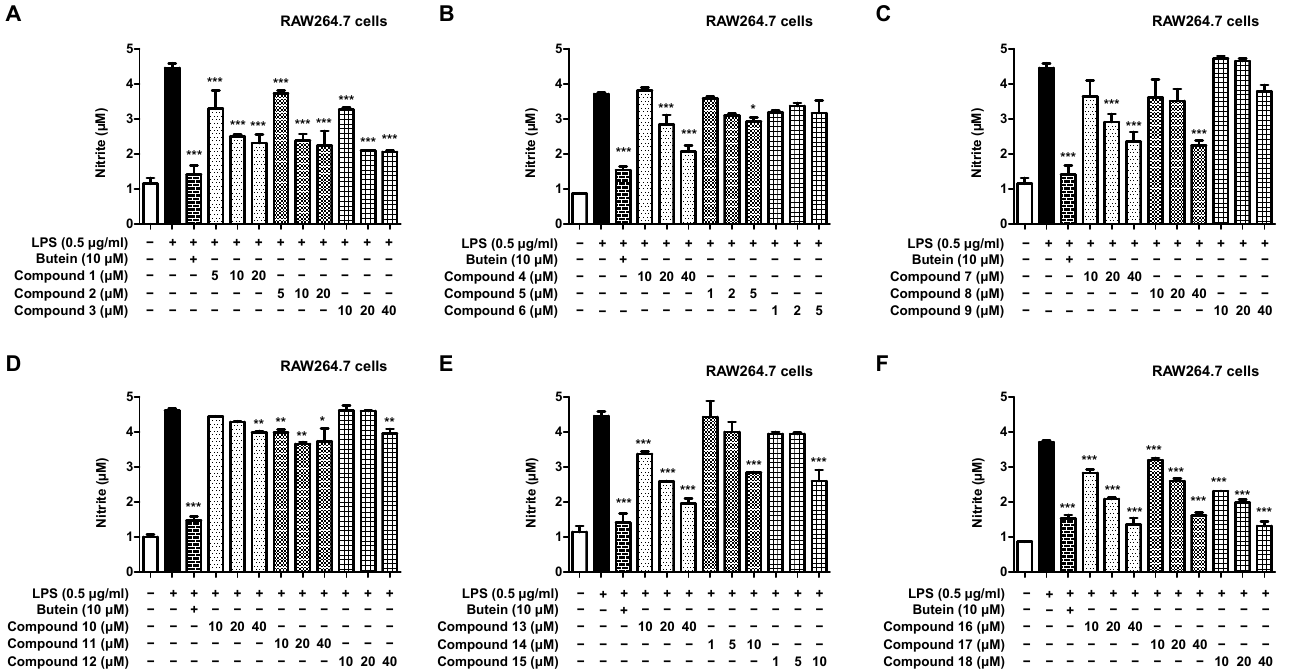
Figure 5. Inhibitory effect of the 18 natural compounds on nitrite production in RAW264.7 macrophage cells ( A – F ). The inhibitory effect on nitrite production in RAW264.7 cells was induced for 18 h by pretreatment with the compounds at a concentration of 1–40 µ M followed by treatment with LPS. Data are expressed as the mean ± standard deviation value of three independent experiments. * p < 0.05, ** p < 0.01, *** p < 0.001 vs. LPS.